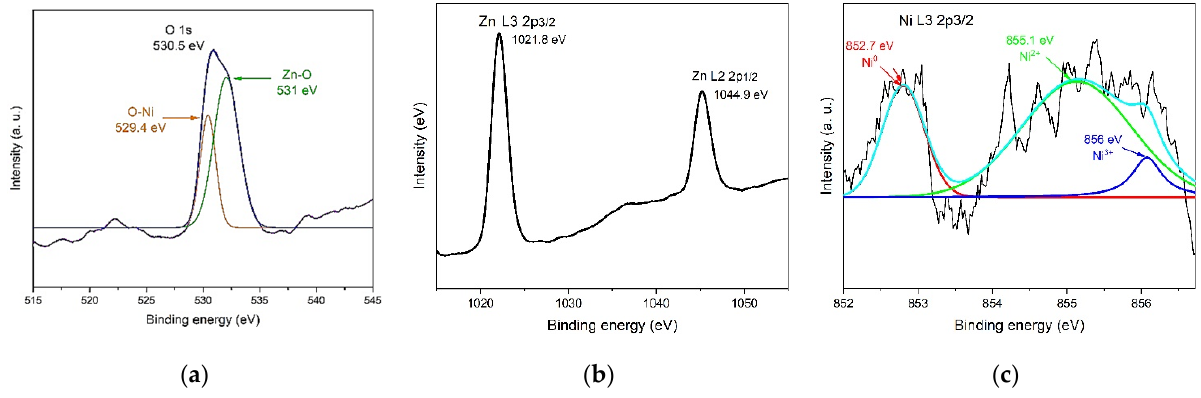
Figure 4. XPS survey spectrum of the sample A1. ( a ) O 1s, ( b ) Zn L3 2p3/2 and L2 2p1/2, ( c ) Ni L3 2p3/2.